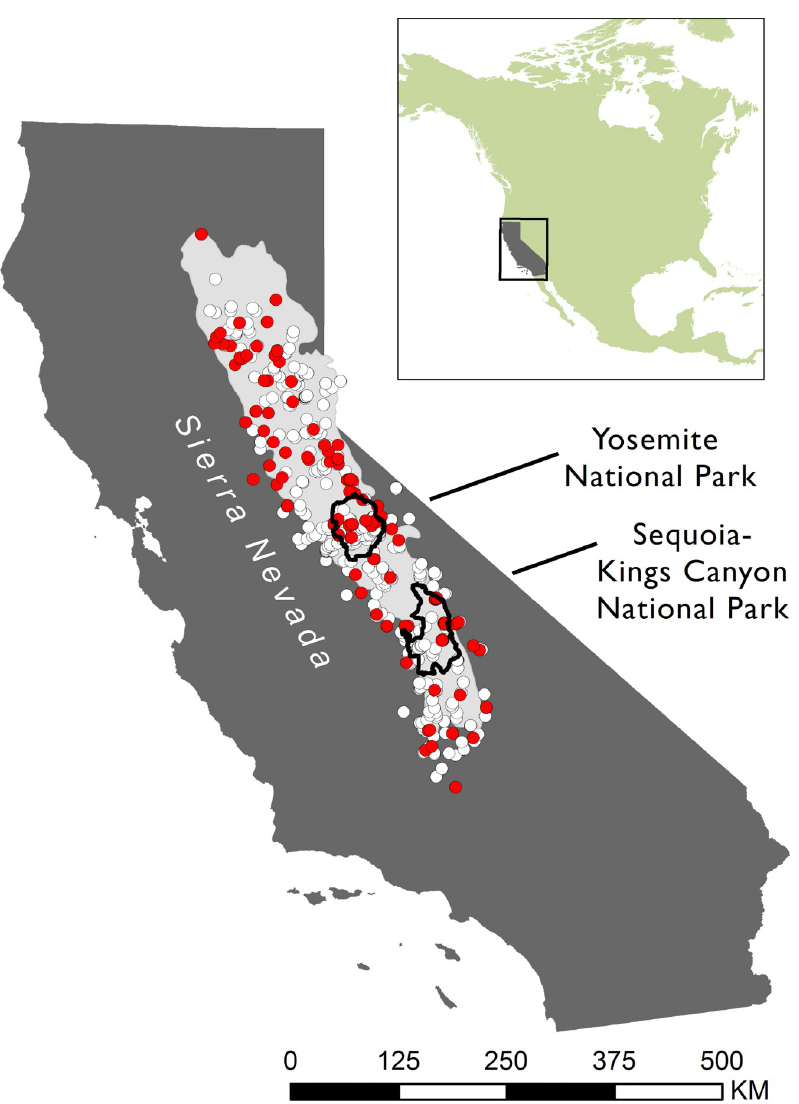
Fig 1. Spatial distribution of 1165 amphibian museum specimens tested for Bd- infection collected between 1900– 2005 in the Sierra Nevada. Red and gray circles denote individuals tested positive and negative for Bd ; respectively.